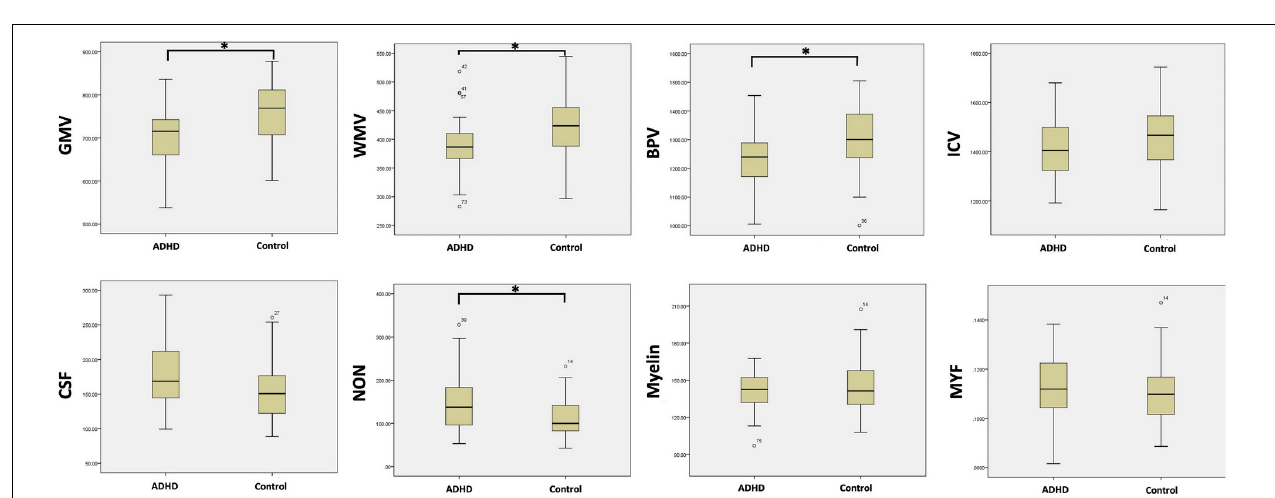
FIGURE 4 | The comparison of the brain tissue and myelin volume between ADHD group and control group with the measurements acquired by SyMRI ( ∗ p < 0.05).